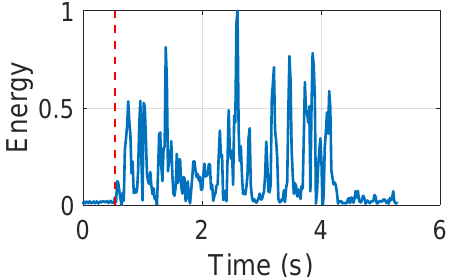
Figure 3. Adaptive energy-based initial pulse